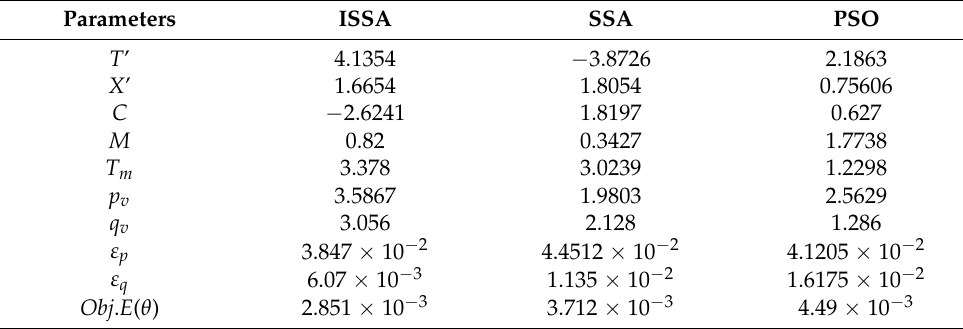
Table 3. Parameter identification values and errors for the three